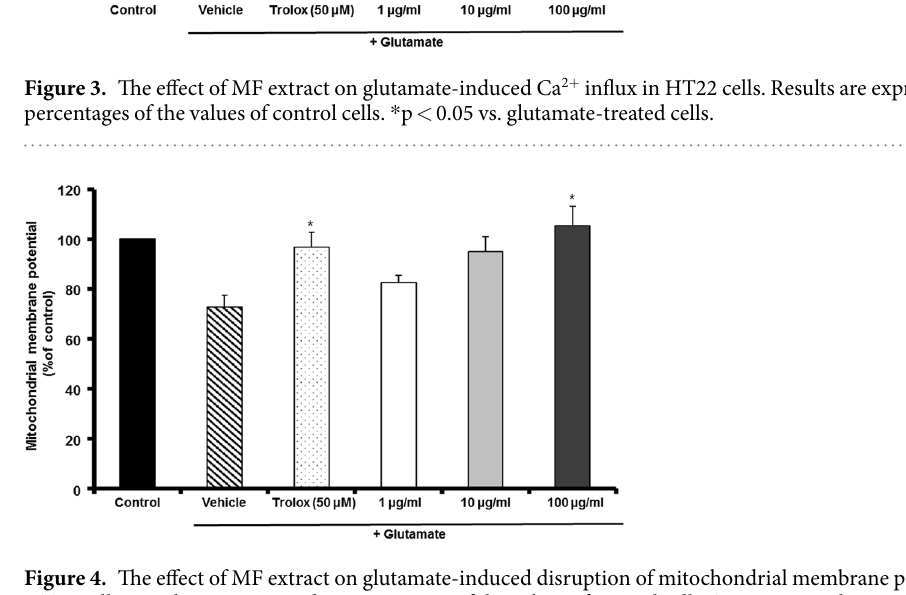
Figure 4. The effect of MF extract on glutamate-induced disruption of mitochondrial membrane potential in HT22 cells. Results are expressed as percentages of the values of control cells. * p < 0.05 vs. glutamate-treated